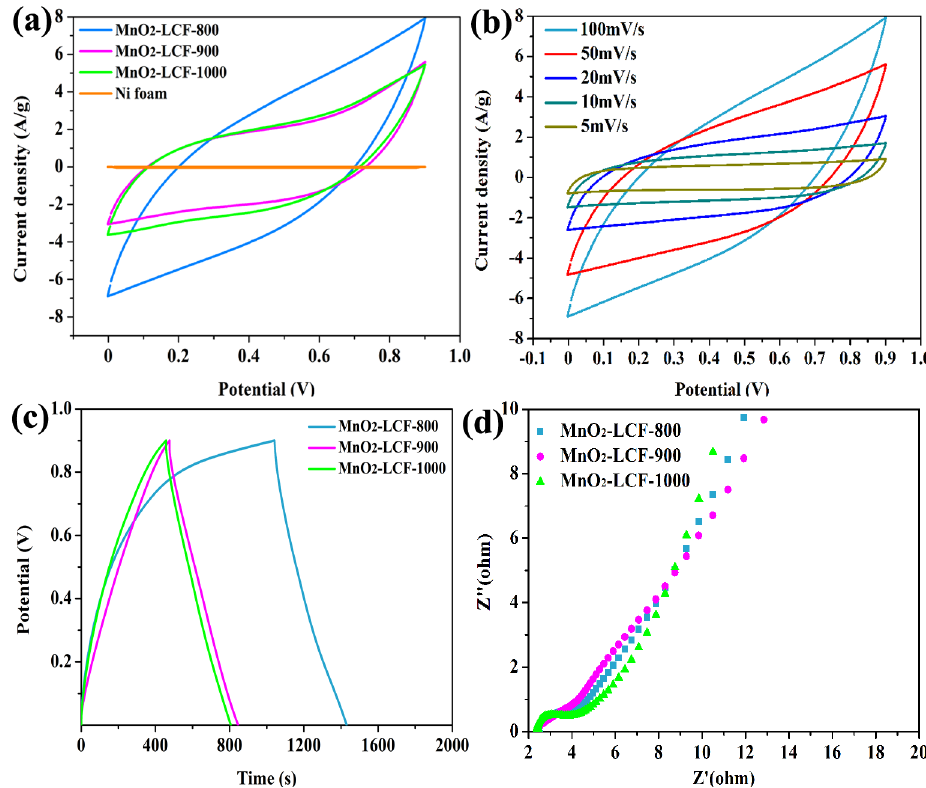
Figure 6. CV curves of the MnO 2 -LCF mat electrodes at a constant scan rate of 100 mV ∙ s − 1 within the potential range of 0–0.9 V ( a ), CV curves of the MnO 2 -LCF-800 mat electrode at different scan rates within the potential range of 0–0.9 V ( b ), GCD curves the MnO 2 -LCF mat electrodes at the current density of 0.3 A ∙ g − 1 ( c ), Nyquist plots of the MnO 2 -LCF mat electrodes ( d ).